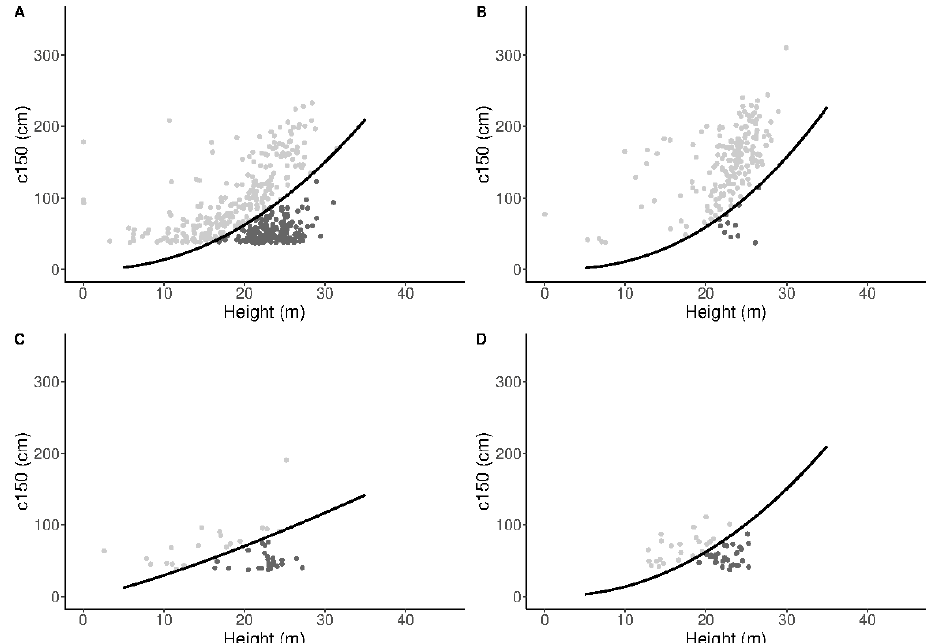
Figure 5. Tree detectability status assessment for independent plots by species: ( A ) beech, ( B ) oak, ( C ) spruce, and ( D ) other. Black lines correspond to models adjusted on smallest c150 per 2 m height class using the FMI crown dataset. Darker dots are undetected